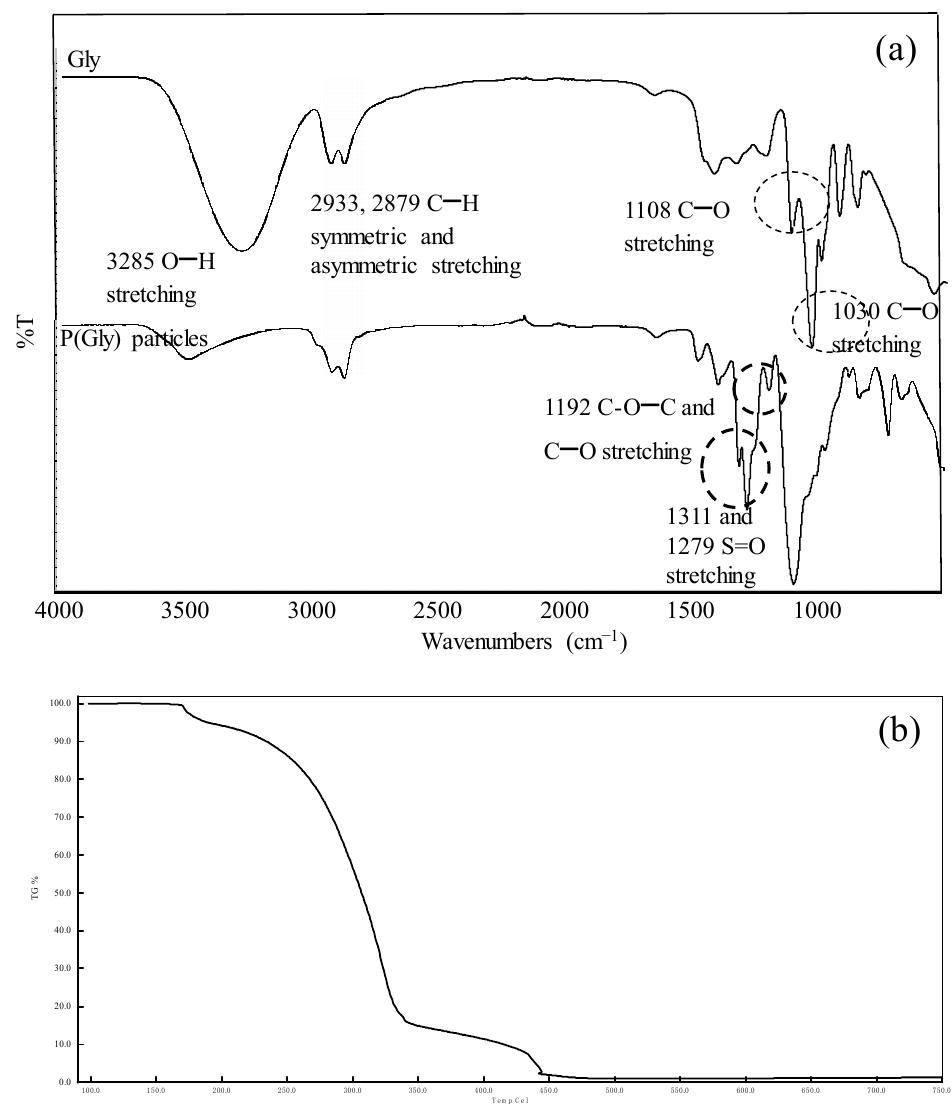
Figure 2. ( a ) FT-IR spectra of Gly and p(Gly) particles (75x), and ( b ) TG thermograms of p(Gly) particles.